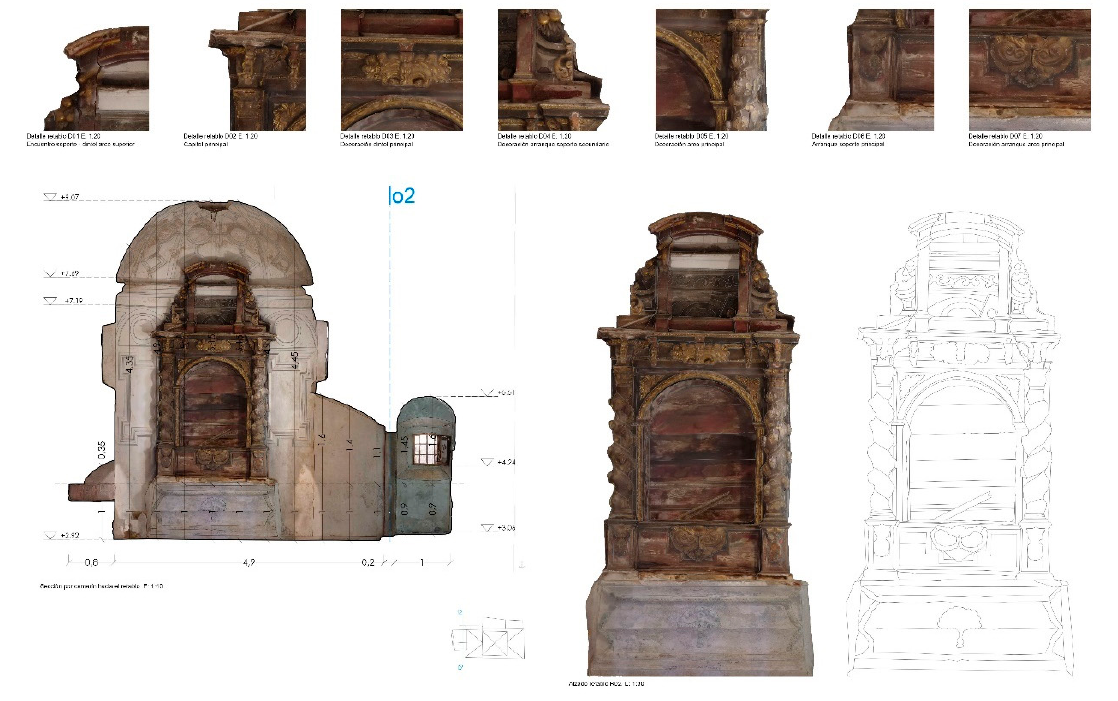
Figure 7. Architectural and pathological analysis of the chapel and the altarpiece located at the back of the hermitage. The study highlights the need to document this unique piece from the 18th century to guarantee its conservation. It has suffered substantial degradation. The boards are very deteriorated due to humidity, the pictorial decoration has been lost, and there are detached boards and serious structural